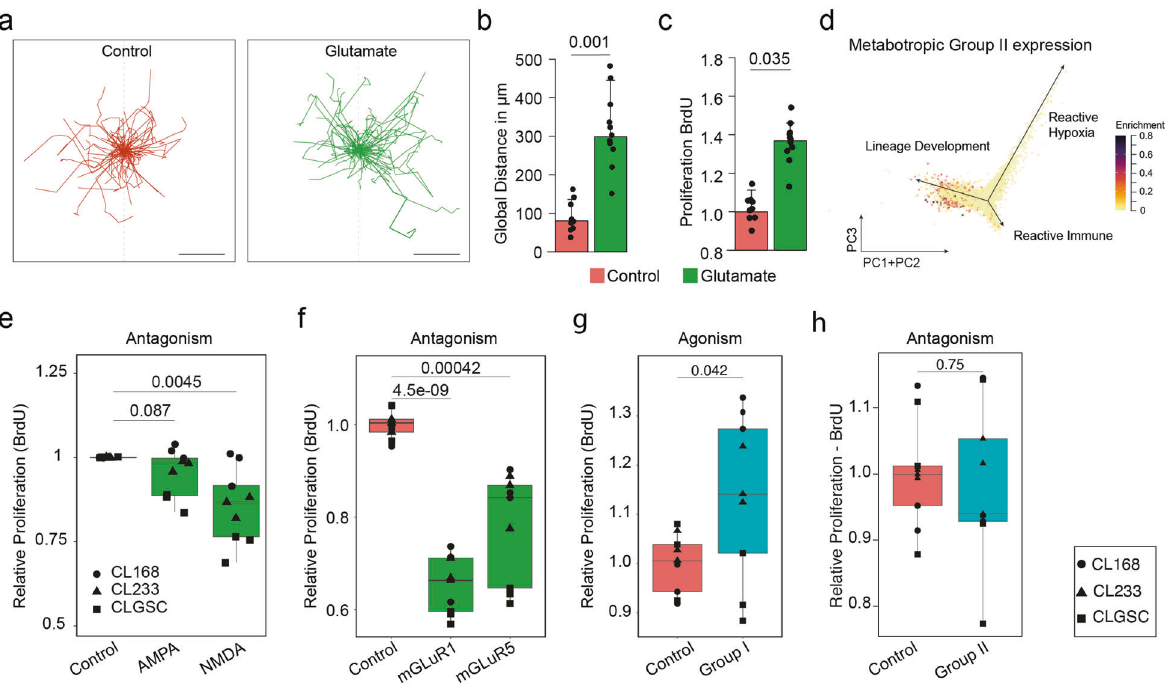
Fig. 2 Glutamate receptors and their function in GBM. a Glutamate stimulation shows that there is a signi fi cant increase in the movement in comparison to unstimulated controls ( n = 24 cells each). Scale bar = 50 μ m. b Quanti fi cation of the global distance traveled shows that there is a signi fi cant increase in the global distance traveled by GBM cells that are stimulated with glutamate vs unstimulated controls ( n = 24 each, p = 0.001). d Expression of Metabotropic Group II receptors was localized to the lineage subtype of GBM cells, with minimal expression in the reactive subtypes. e Antagonism of AMPA and NMDA receptors revealed that only the inhibition of NMDA receptors resulted in a decrease in cell proliferation ( n = 9, p = 0.0045). f Antagonism of Group I metabotropic receptors (mGLuR1 and mGLuR5) resulted in a signi fi cant reduction in cell proliferation ( n = 9, p < 0.001). g Agonism of Group I receptors signi fi cantly increased the proliferation of GBM ( n = 9, p < 0.05). h Agonism of Group II metabotropic receptors show no change in proliferation ( n = 9, p > 0.05). All box plots represent median, with hinges representing 25th and 75th percentile and whiskers representing 1.5x Interquartile